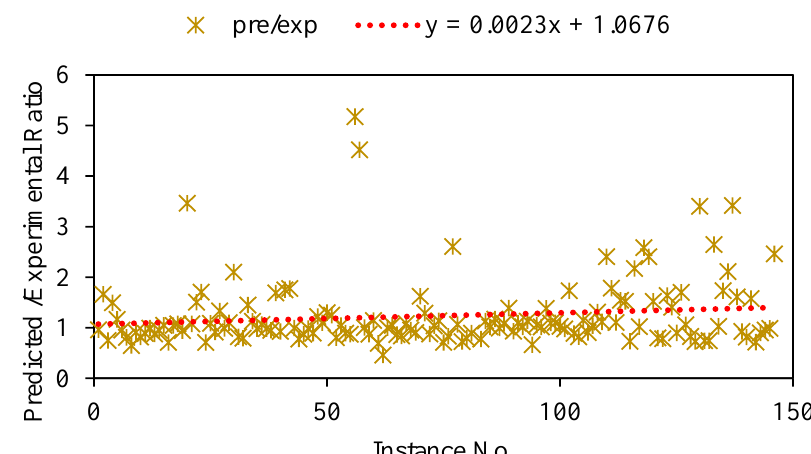
Figure 7. Predicted/experimental ratio for the optimum trial.